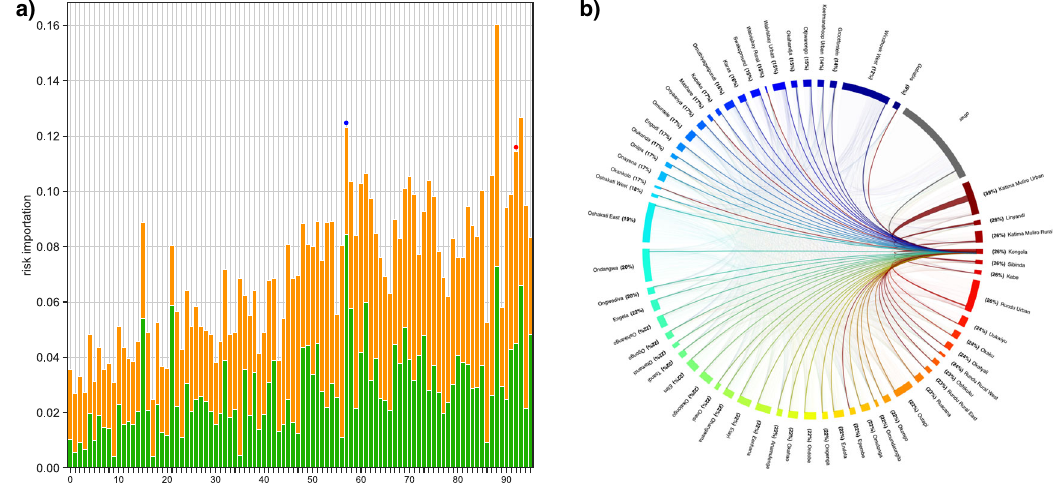
Fig. 3 Importation of risk. a Histogram showing the importation of risk for men into each constituency. The y -axis shows the value for imported risk; a mathematical de fi nition of imported risk is given in the methods (Eq. 5). The numbers on the x -axis refer to speci fi c constituencies; the key code is given in Supplementary Table 4. Constituencies are ordered by increasing HIV prevalence in women: from 6 to 39%. The constituency of Oshakati East is labeled with a blue dot, the constituency of Kongola with a red dot. Orange data show the risk for men that was imported into each constituency due to travel by their uninfected male residents. Green data show the risk for men that was imported into each constituency due to visits from HIV-infected women, who lived in other constituencies. The stacked value represents the total amount of imported risk. b Chord diagram showing the in- fl ow risk network for men in Kongola; the lines represent risk importation due to uninfected male residents of Kongola visiting other constituencies. The thickness of the lines is proportional to the amount of imported risk. 4 NATURE COMMUNICATIONS| (2021) 12:2837